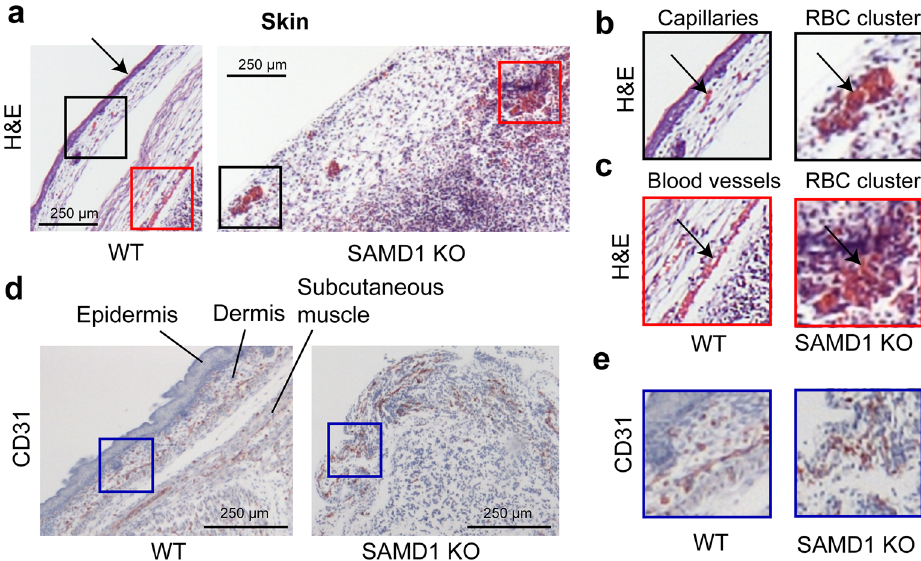
Figure 3. E14.5 SAMD1 KO mice have clusters of RBCs and disorganized and damaged endothelial cells (ECs) in the skin. ( a ) H&E staining of embryo skin. ( b ) Higher magnification showing capillaries. Arrows indicate capillary (WT) or RBC clusters (KO). ( c ) Higher magnification of blood vessels (WT) or RBC clusters (KO) are indicated by arrows. ( d ) CD31 (brown) staining of embryo skin ( e ) Higher magnification of CD31 ECs in capillaries in WT skin and disordered structures in KO